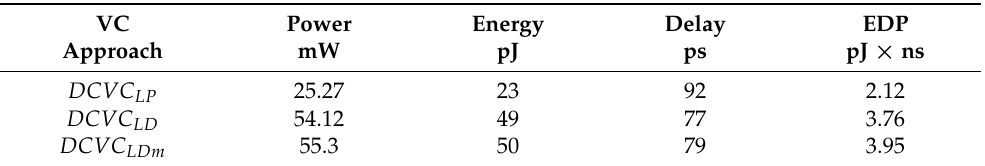
Table 2. Power, energy, delay, and energy-delay-product (EDP) obtained using a signal input of 0.2 Vp @ 1.1 GHz.